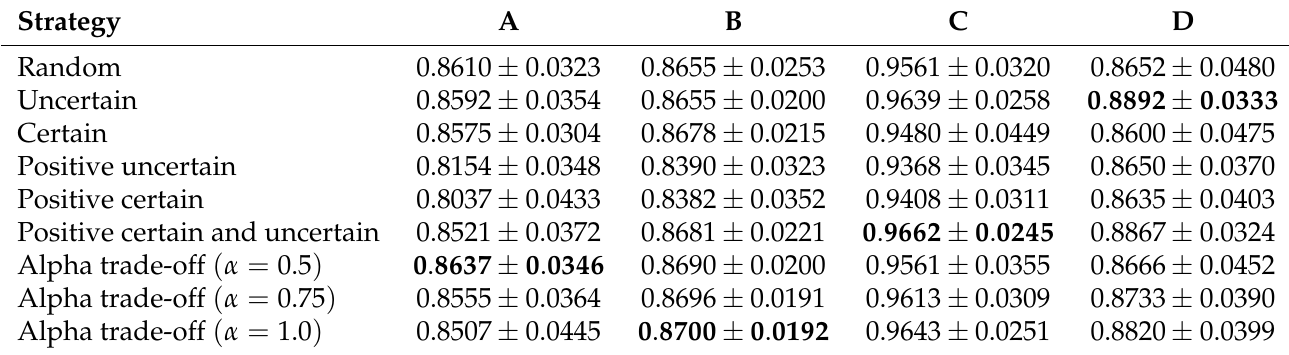
Table 5. Mean ROC AUC score with standard deviation, aggregated over used models and representations, for each strategy, reported on each of the four datasets. The best score for each dataset is shown in bold. A–D correspond to the four datasets we used to conduct the experiments, which are described in Table 2.